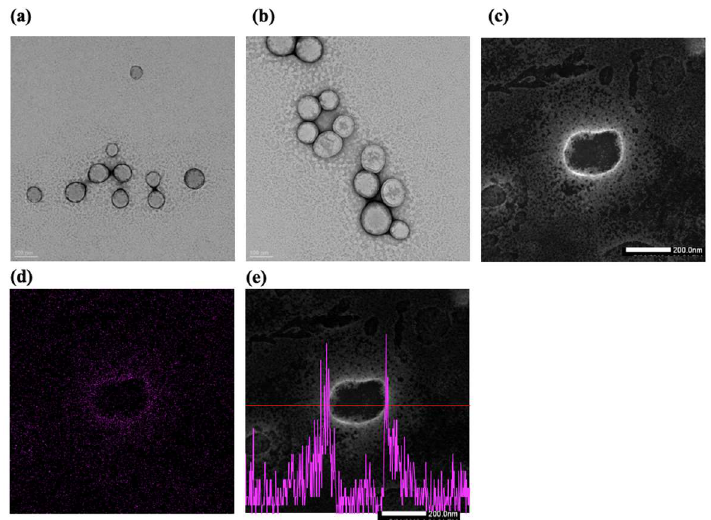
Figure 4. Transmission electron microscopy images of PT-NLC ( a ) and P-PT-NLC ( b ). scanning transmission electron microscopy-energy dispersive X-ray spectroscopy (STEM-EDS) image ( c ), EDS mapping image of uranium elements ( d ) and STEM-EDS line analysis ( e ) of P-PT-NLC.